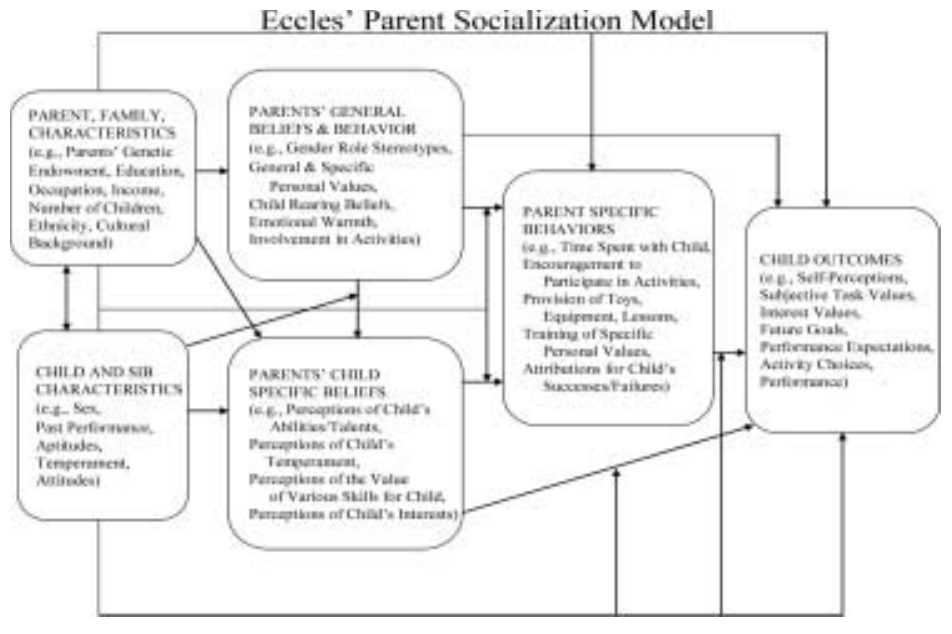
Figure 1. Eccles et al . parent socialization